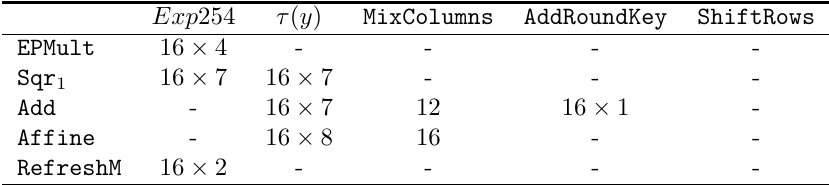
Table 5: The number of SMC operations in one round of AES.